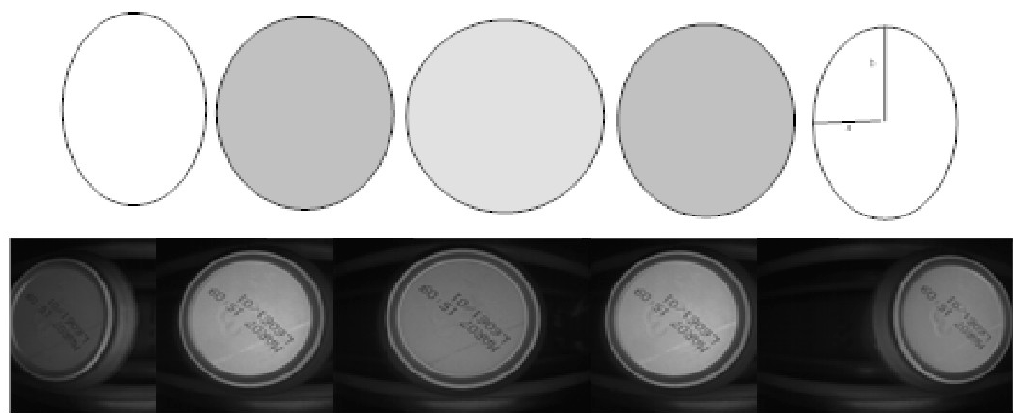
Figure 4. Elliptical areas of interest with different eccentricities according to their location. MONICOD uses the ellipse outline for detection and the area enclosed by the ellipse for extraction. This article describes a model using the circumference as the area of interest.